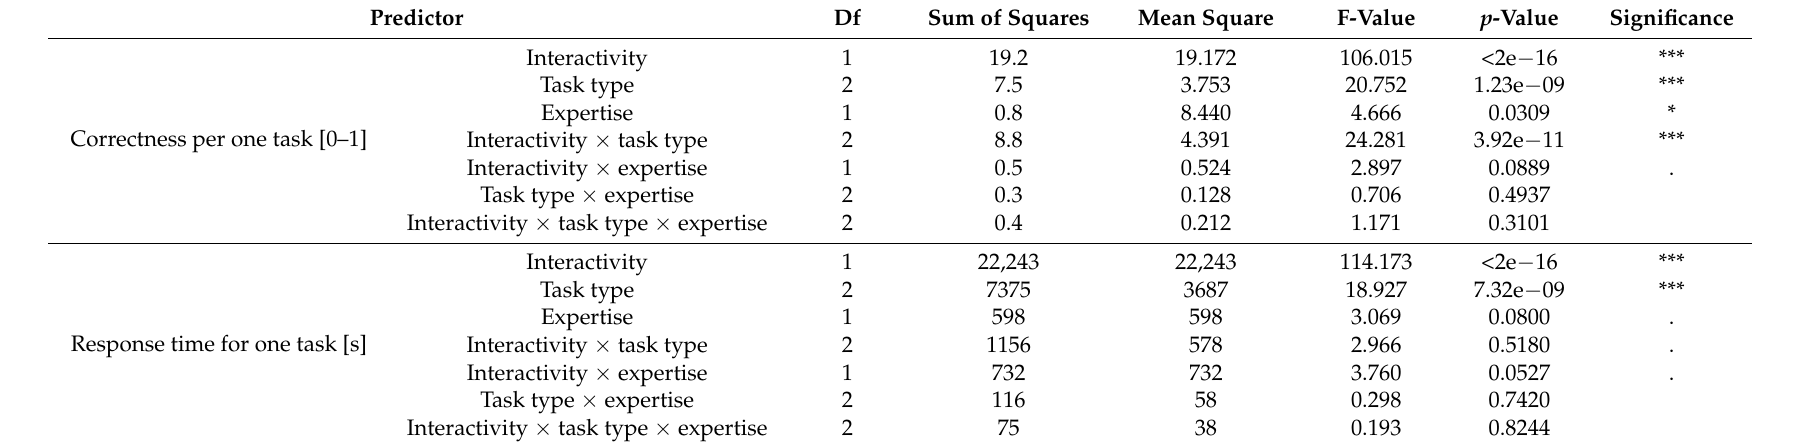
Table 4. ANOVA results—correctness and response times. Sum of Squares Mean Square p -Value